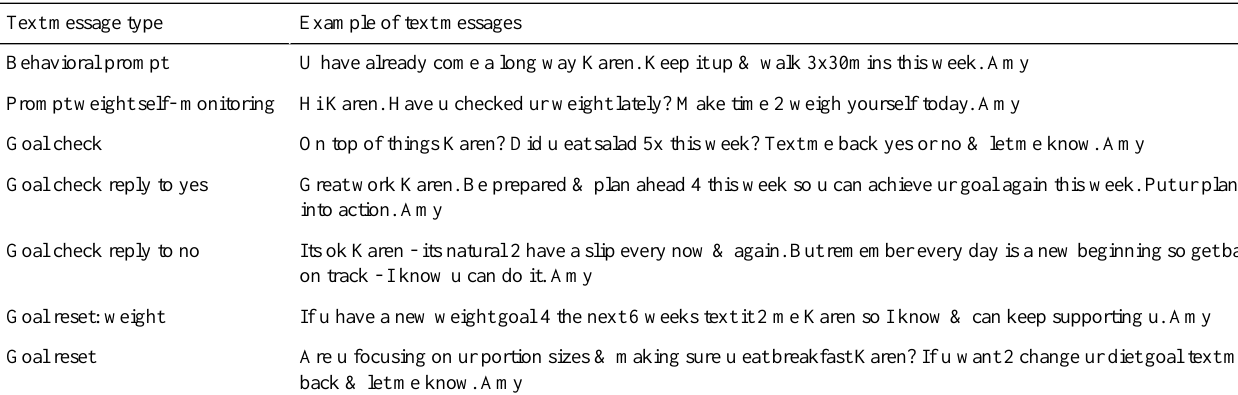
Table 1. Examples of the types of text messages sent during the intervention.